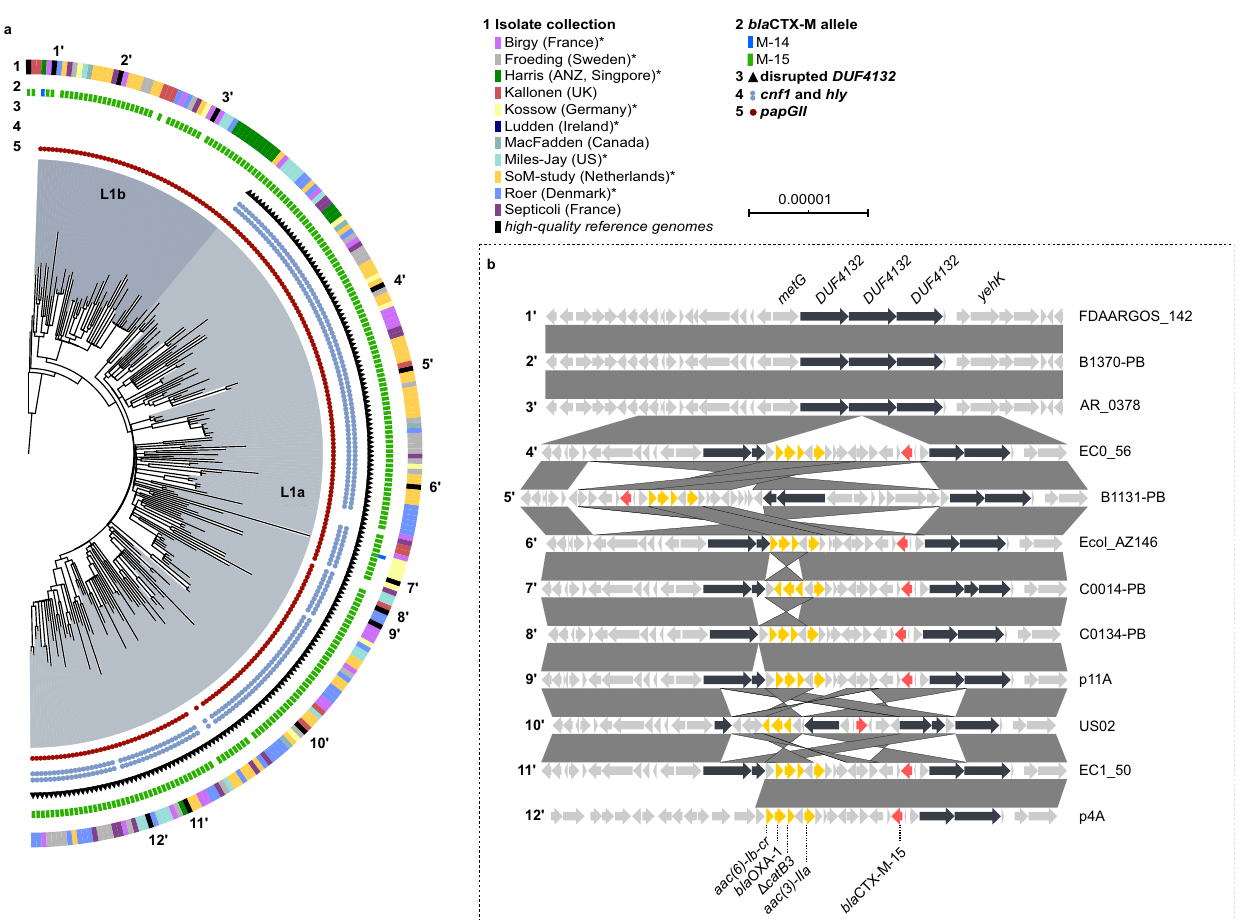
Fig. 4 Phylogeny and characteristics of the dominant ST131 papGII + sublineage L1 (clade C2). a Maximum-likelihood phylogenetic tree of 236 isolates of the clade C2 branch encompassing the dominant papGII + sublineage L1 (including 6 papGII -negative isolates) and EC958 (clade C2) as outgroup. The tree is based on 2,790 variable sites in a 3.4 Mb core genome alignment. The two major subbranches (L1a and L1b) of L1 are shaded in different colours. Each isolate is annotated with the source collection (ring 1), bla CTX-M allele (ring 2), disruption of the DUF4132 region (ring 3), and presence of hly , cnf1 (ring 4), and papGII (ring 5). Collections that consisted only of ESBL isolates are labelled with an asterisk in the legend. The number of substitutions per core genome alignment site is indicated by the scale bar. The tree was visualized using iTOL 74 . Numbers at the outermost ring refer to the 12 isolates with high-quality assemblies and resolved DUF4132 region, which are illustrated in panel b. Sublineage L1 was unambiguously de fi ned within the ST131 population by a distinct mtlD allele (encoding a mannitol dehydrogenase family protein; 96% sequence identity to the mtlD allele of other ST131 isolates; Genbank accession number TLH04005.1) b Genetic context of the DUF4132 region in high-quality assemblies from 12 isolates of papGII + sublineage L1. All 9 isolates of subbranch L1a (isolates 4 ′ to 12 ′ ) harboured Tn MB1860 with the resistance genes aac(3)-IIa , aac(6 ’ )-Ib-cr , bla OXA-1, bla CTX-M-15, and Δ catB3 inserted into the chromosomal DUF4132 region. Vertical boxes between sequences indicate shared homologies (100% identity). Sequence comparisons were performed using EasyFig 64